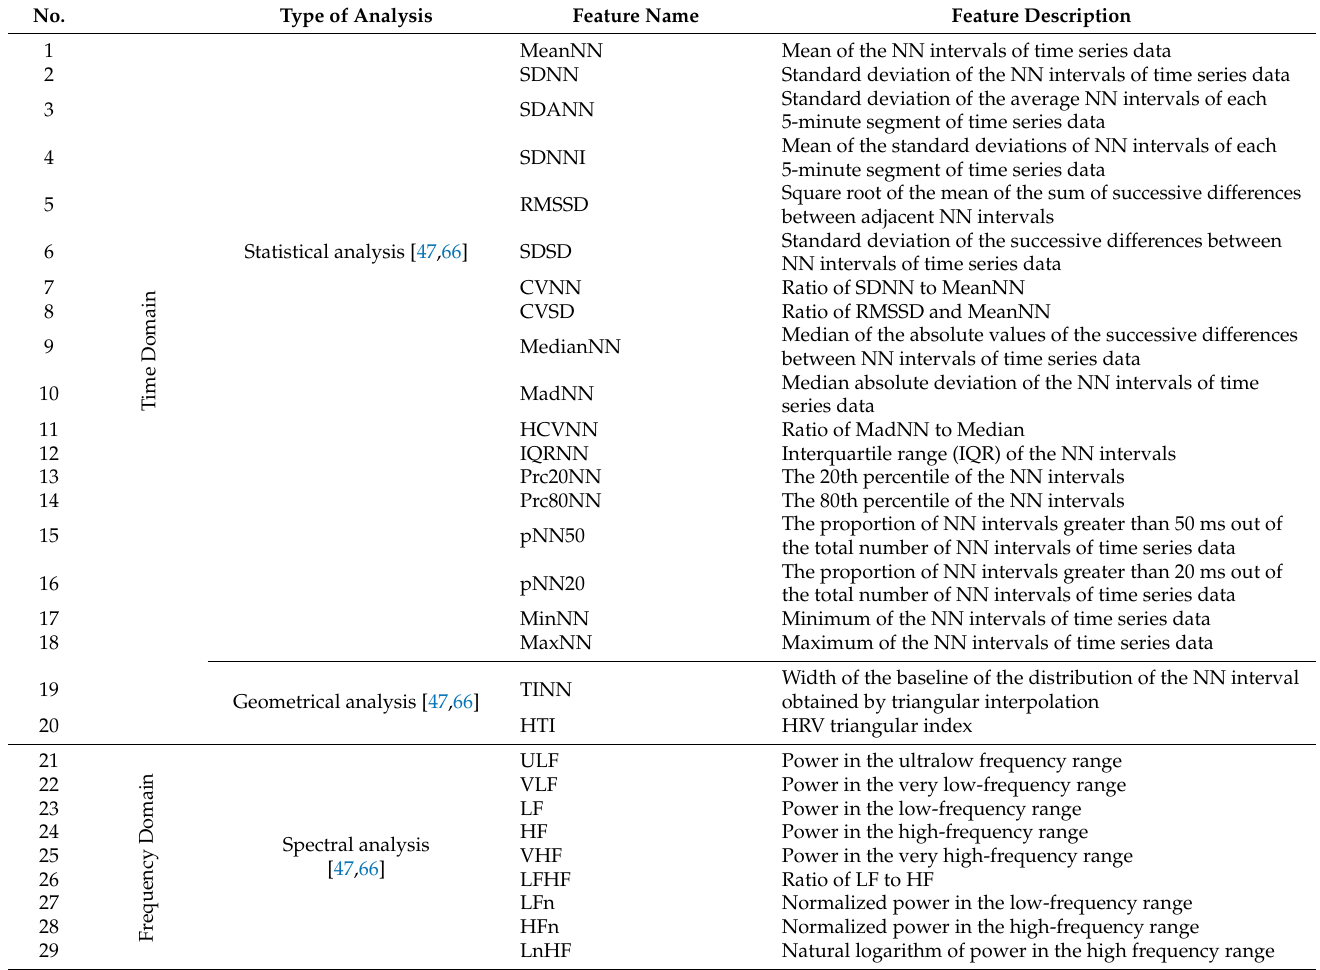
Table 4. List of extracted features of NN interval data in time and frequency domain